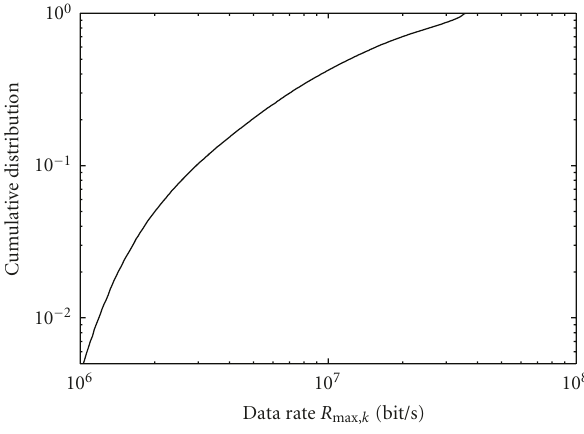
Figure 7: CDF of maximum data rate R max, k , which characterizes the communications channel on the link